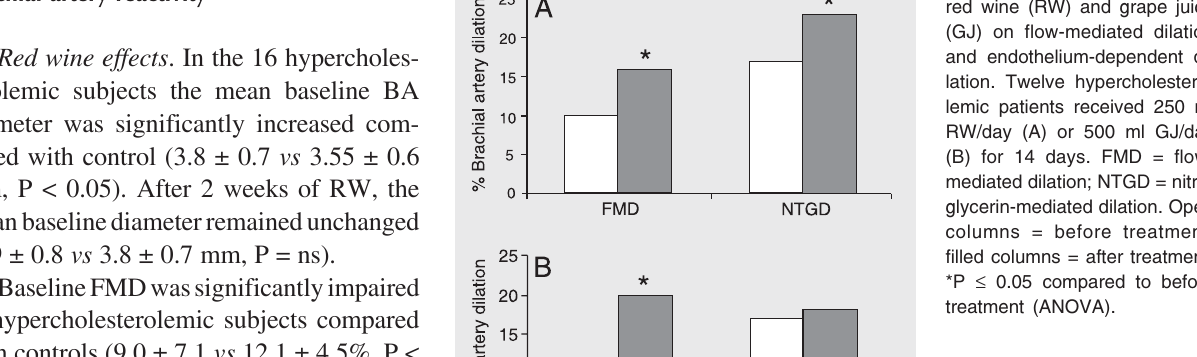
Figure 1. Effect of ingestion of red wine (RW) and grape juice (GJ) on flow-mediated dilation and endothelium-dependent di- lation. Twelve hypercholestero- lemic patients received 250 ml RW/day (A) or 500 ml GJ/day (B) for 14 days. FMD = flow- mediated dilation; NTGD = nitro- glycerin-mediated dilation. Open columns = before treatment; filled columns = after treatment. *P ≤ 0.05 compared to before treatment